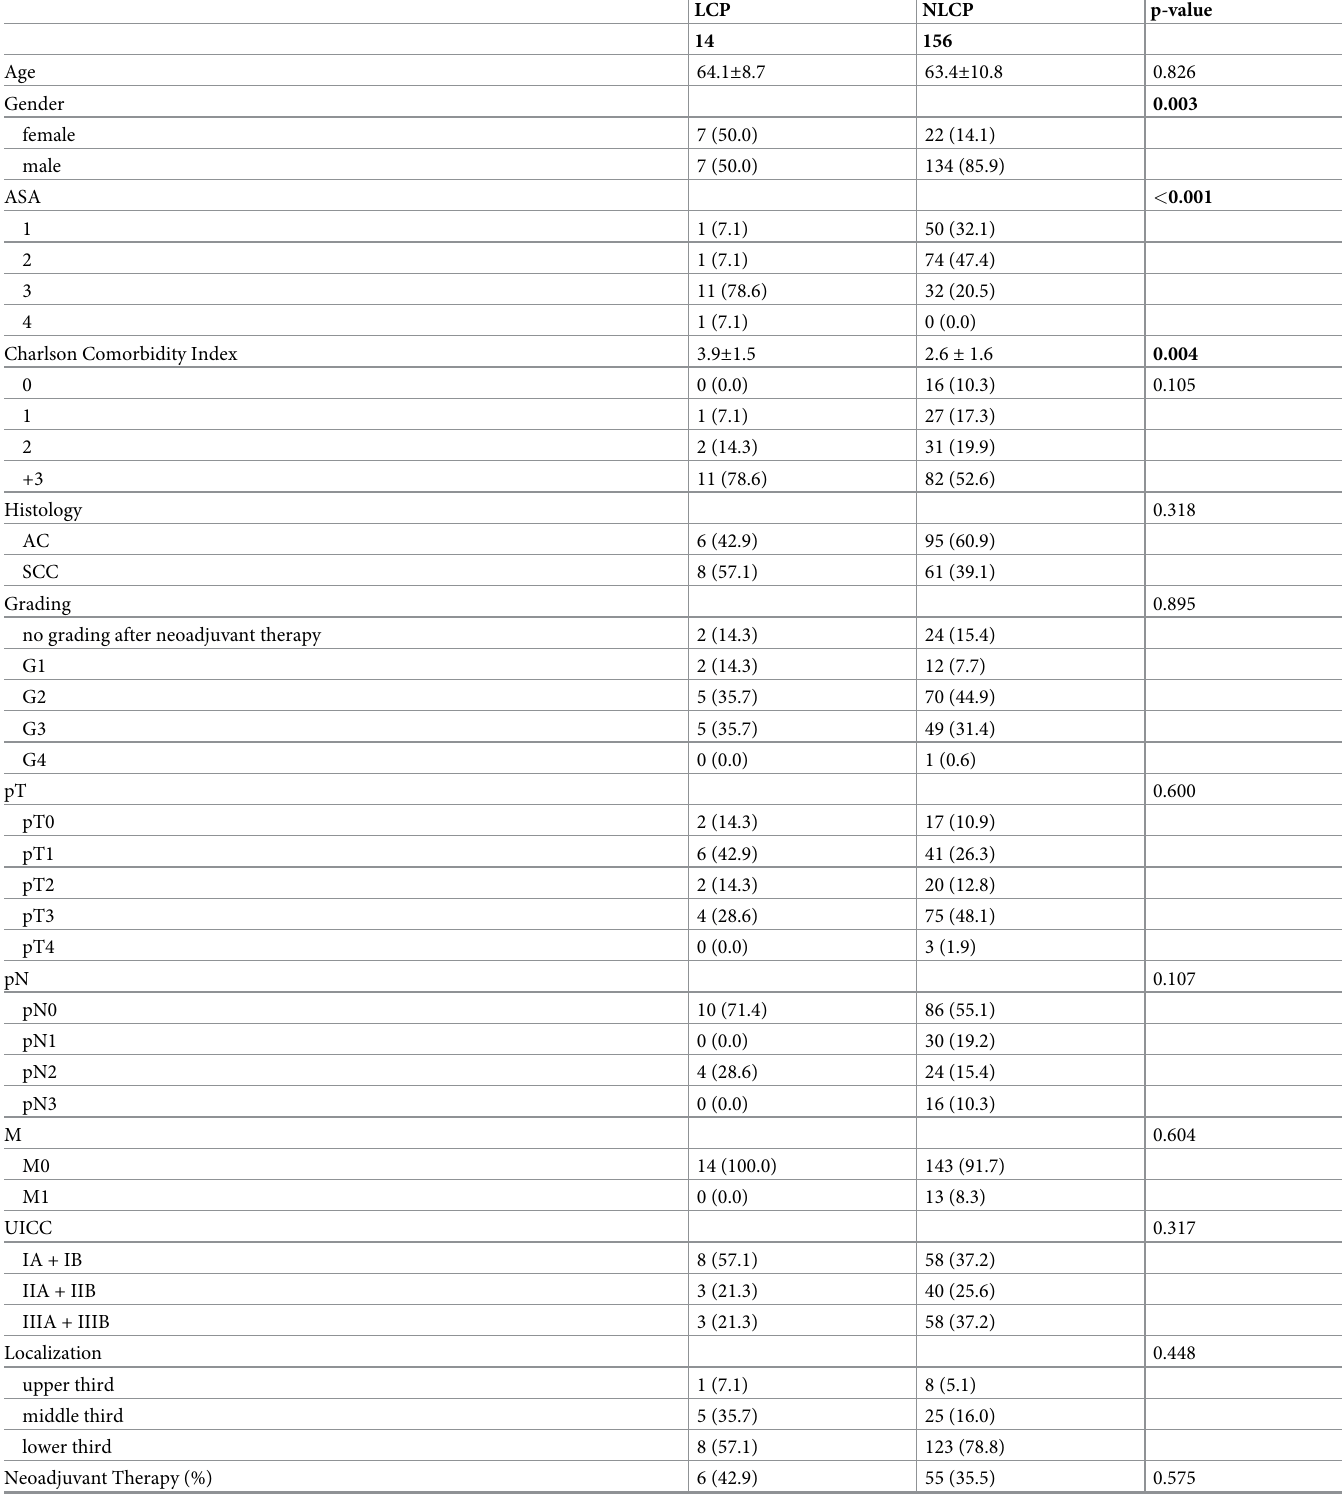
Table 1. Clinicopathological parameter of cirrhotic and non-cirrhotic